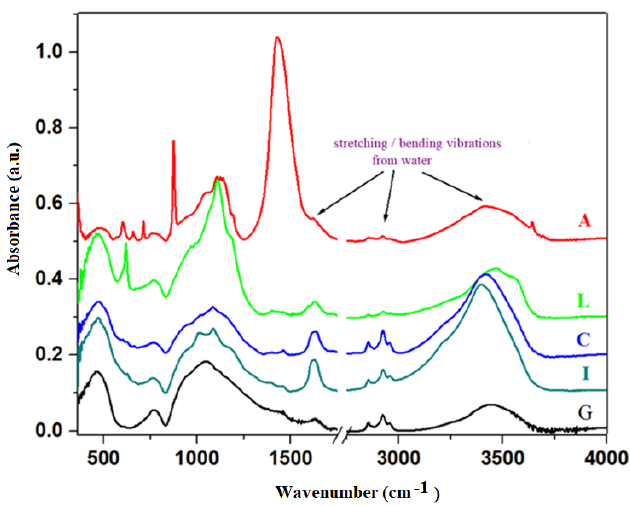
Figure 2. Fourier transform infrared (FTIR) spectra of waste glass powder and prepared composite